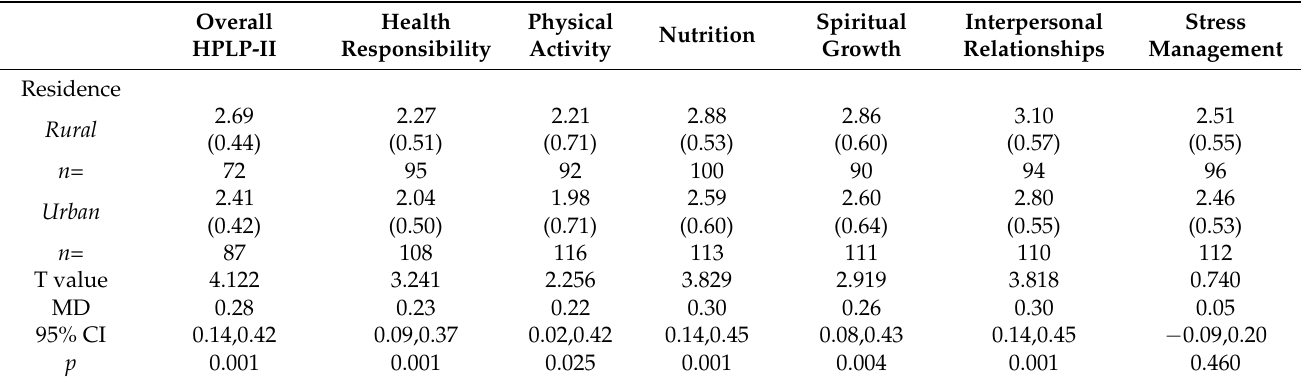
Table 3. HPLP II: rural–urban comparison.